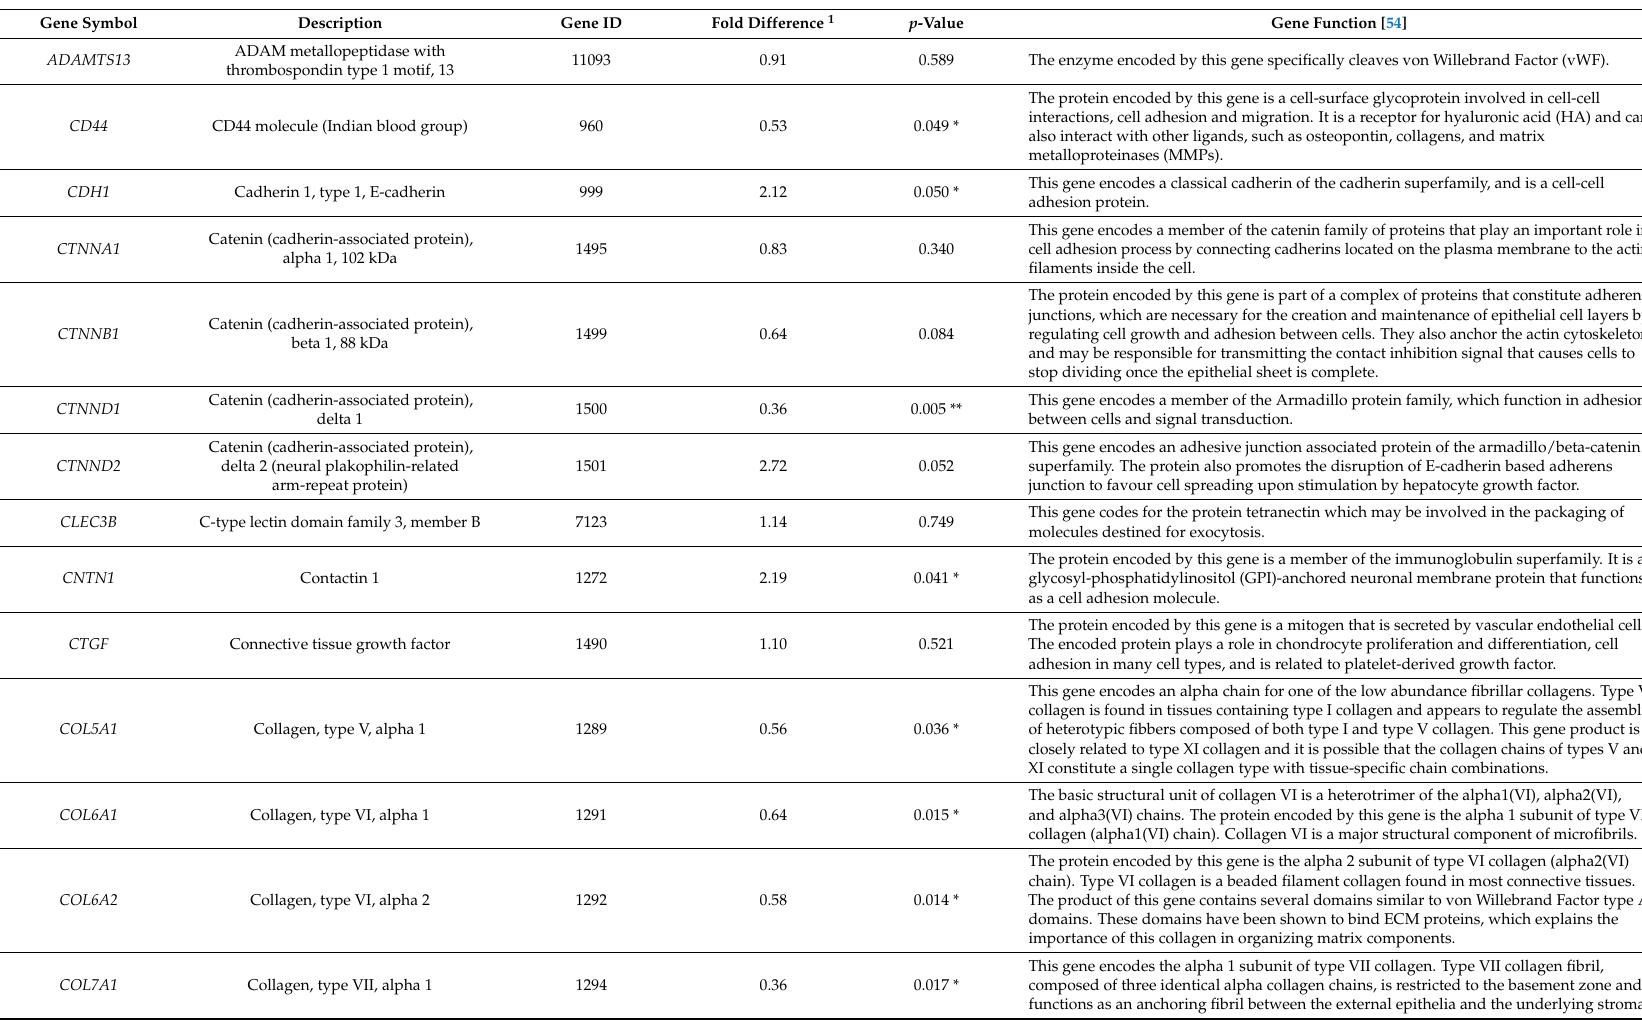
Table 3. Gene expression profile of CAMs in diabetic wounded human skin fibroblast cells irradiated at 660 nm with 5 J/cm 2 . * p ≤ 0.05; ** p ≤ 0.01; *** p ≤ 0.001. Gene